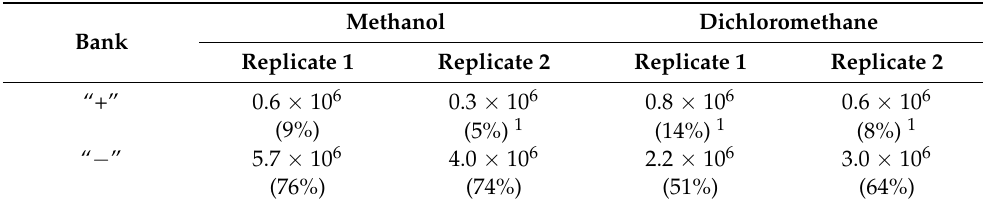
Table 1. Number of aligned reads on M. extorquens DM4